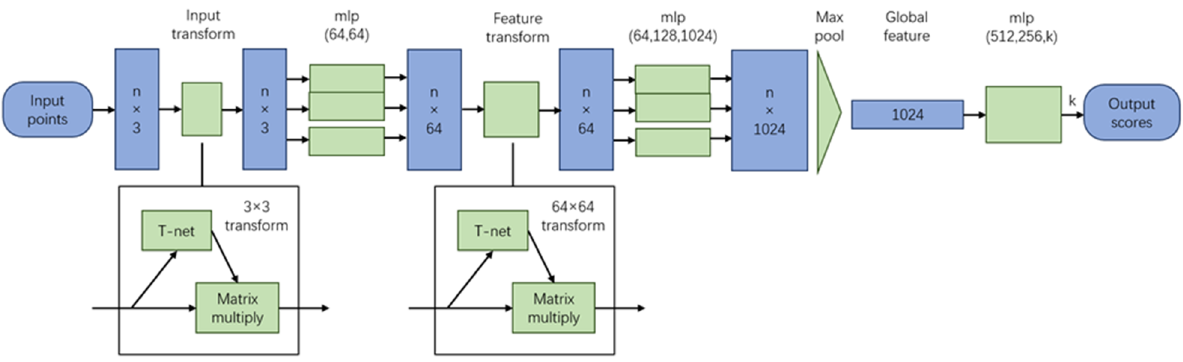
Figure 6. Basic PointNet model structure used in this article.